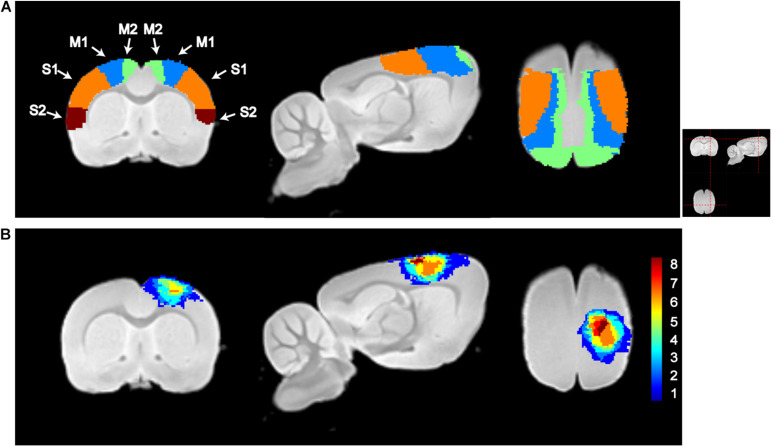
Illustration of sensorimotor cortex and lesion locations. (A) Segmentations of the primary motor cortex (M1), secondary motor cortex (M2), primary somatosensory cortex (S1), and secondary somatosensory motor cortex (S2). (B) Lesion maps of all subjects in the lesion group. The color in each voxel represents the number of rats with lesion in that voxel. M1, M2, S1, S2, and lesion maps were visualized by overlapping on the T2-weighted template, which was constructed using the structural images of the control group. From left to right, it is the coronal, sagittal, and axial views of the image. The red dashed lines in the top-right picture show the location for slices shown in (A,B).